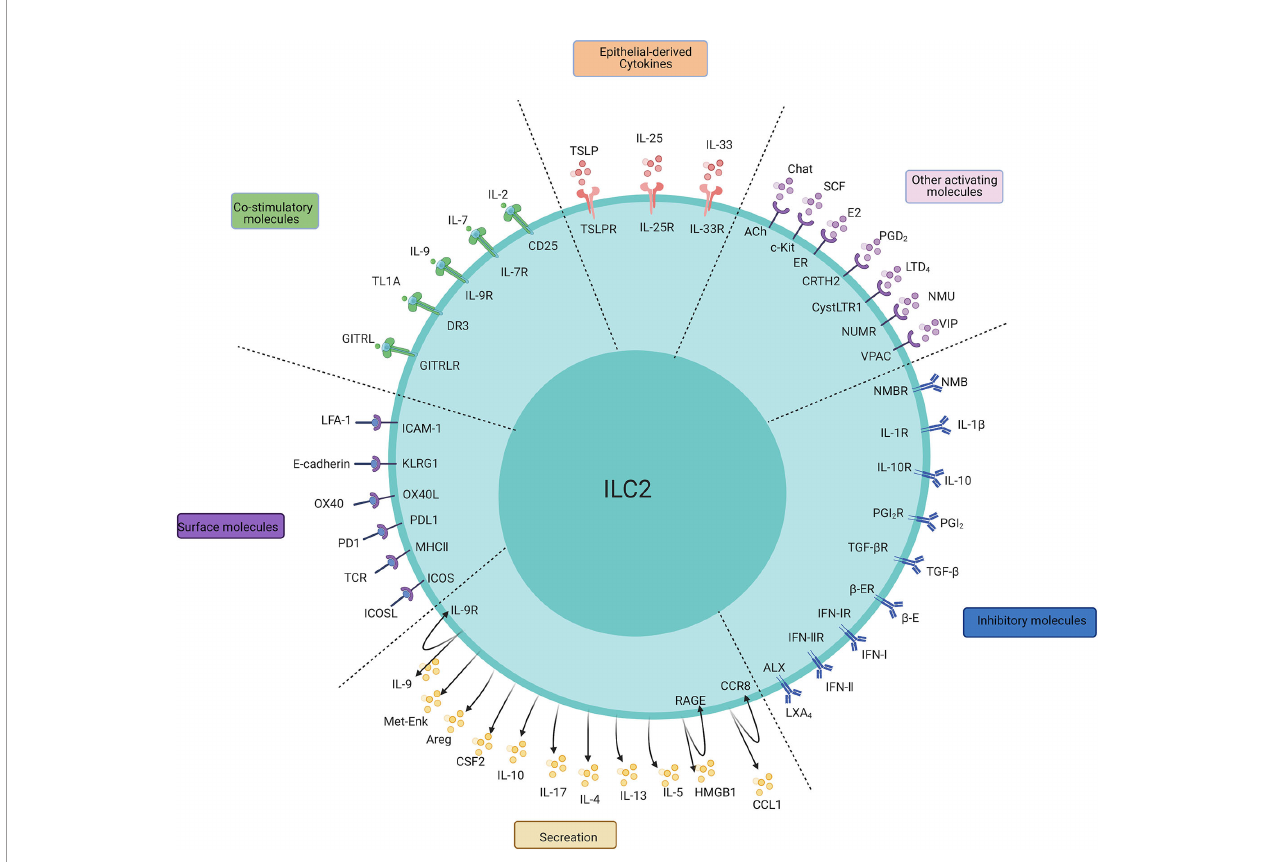
FIGURE 1 | The main regulatory factors, surface molecules, and secretion of ILC2s. The PMIDs of relative articles: IL-1 b : 32086822; IL-25:20023630,22079492; IL-33:21909091,23810766; TSLP:22425247,26129648, 29296700; IL-2:26595888; IL-7:24388011; IL-9:21983833; TL1A:24220298,24368564; GITRL: